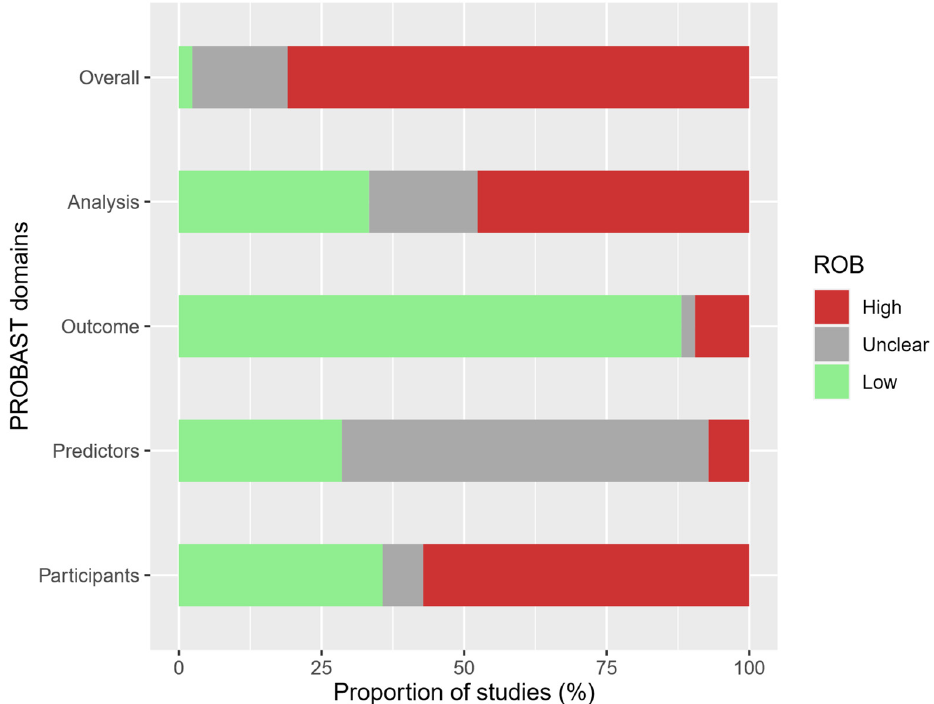
Figure 1. Risk of bias rating overall and per domain ( n = 42 studies).